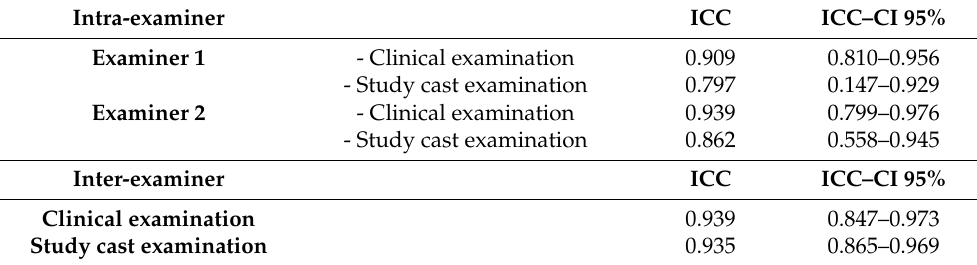
Table 1. Intra-examiner and inter-examiner reliability scores tested with the ICC. The scores show that there is good conformity within and between both